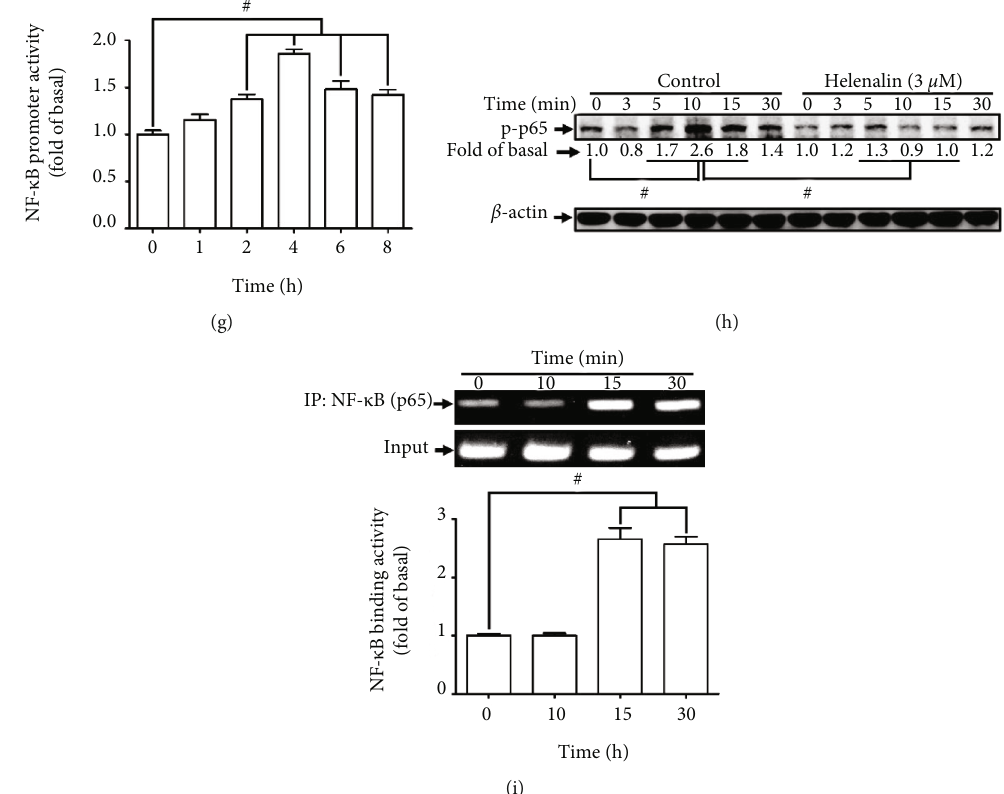
Figure 5: Thrombin induces COX-2 expression via NF- κ B. (a) Cells were pretreated with helenalin for 1h and then incubated with thrombin for 6h. The levels of COX-2 protein were determined by Western blot. (b) Cells were pretreated with helenalin (3 μ M) for 1 h and then incubated with thrombin for 4 h. The mRNA levels and promoter activity of COX-2 were determined. (c) The media saved from (a) were used to determine the levels of PGE2 generation. (d) Cells were transfected with either scrambled or p65 siRNA and then incubated with thrombin for 6h. The levels of p65 and COX-2 protein were determined. (e) Cells were transfected with wild-type COX- 2 promoter or mt-NF- κ B COX-2 promoter, and then incubated with thrombin for 4h. The promoter activity of COX-2 was determined. (f) Cells were treated with thrombin for the indicated time intervals. The nuclear and cytosolic fractions were prepared and subjected to Western blot using an anti-p65 antibody. GAPDH and lamin A were used as a marker protein for cytosolic and nuclear fractions, respectively. (g) Cells were treated with thrombin for the indicated time intervals. The promoter activity of NF- κ B was determined. (h) Cells were pretreated without or with helenalin (3 μ M) for 1 h and then treated with thrombin for the indicated time intervals. The levels of phospho-p65 were determined by Western blot. (i) Cells were treated with thrombin for the indicated time intervals. The NF- κ B p65 binding activities were analyzed by a ChIP assay. Data are expressed as mean ± S : E : M : of three independent experiments. # P < 0 : 05 , as compared with the control or pretreatment with inhibitor indicated in the fi